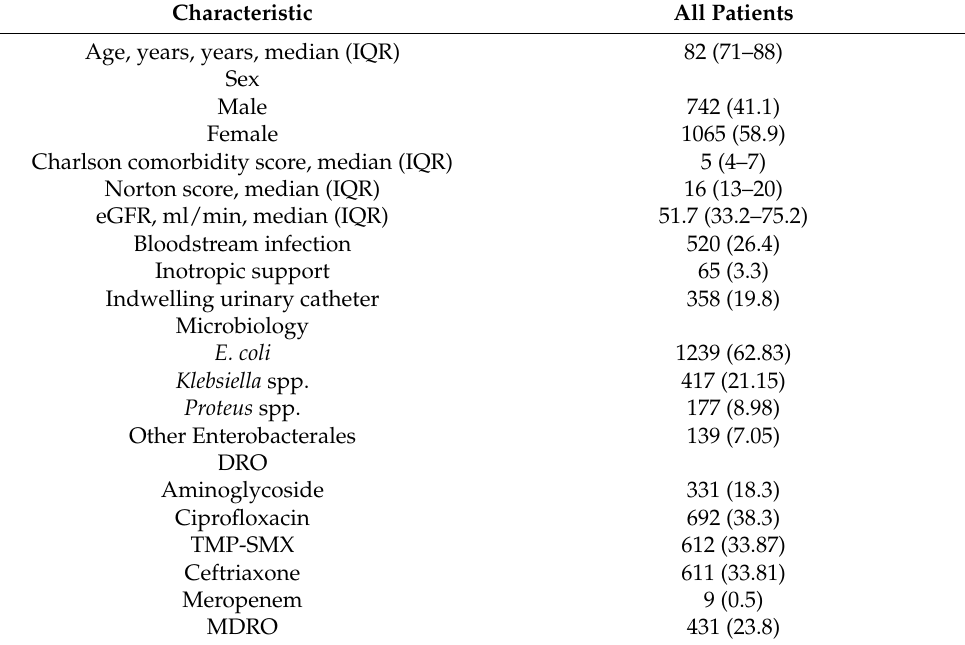
Table 1. Characteristics of 1806 patients with community-acquired pyelonephritis.